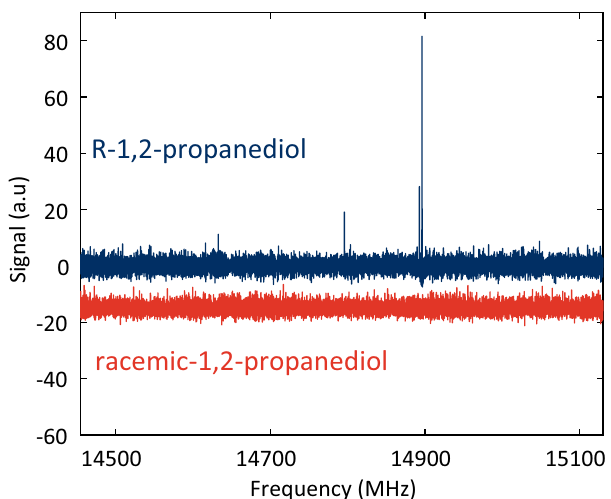
Fig. 3 Three-wave mixing spectra of enantiopure vs racemic samples. (blue) Three-wave mixing spectrum of enantiopure (R)-1,2-propanediol. The three noticeable three-wave mixing signals belong to the two lowest energy conformers of 1,2-propanediol. (red) Three-wave mixing spectrum of racemic 1,2-propanediol. An offset of − 15 (a.u) on the y-axis has been added to the racemic spectrum for clarity to show that no signal survives subtraction as